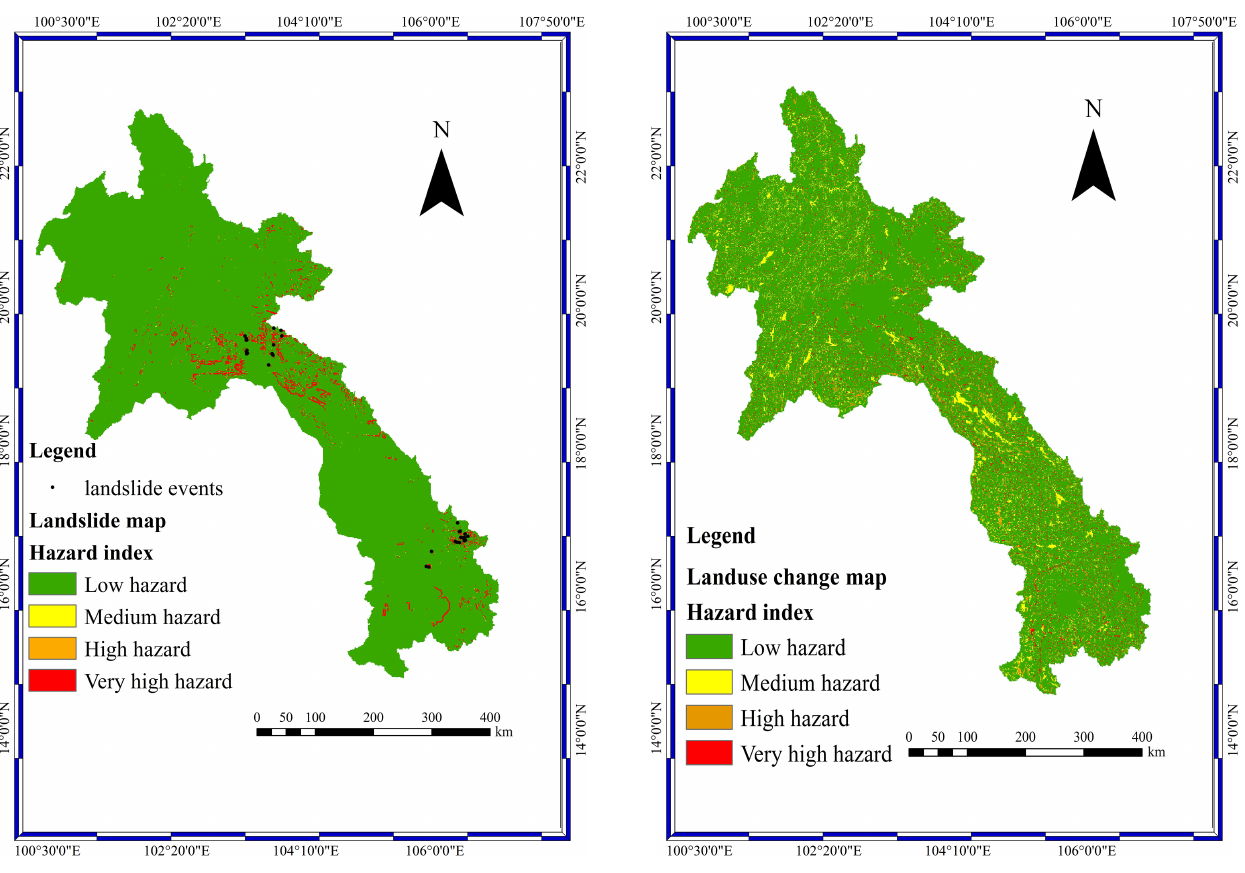
Figure 3. Landslide hazard map and historical landslide events. Figure 4. Land use change hazard